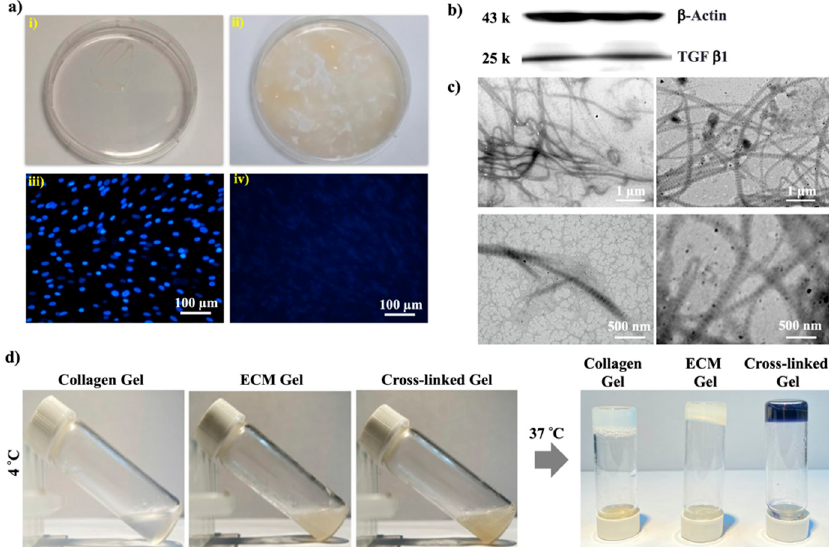
Figure 2. Cell sheet characterization: ( a ) (i) single ADSC sheet, (ii) ASDC sheet collection, (iii) ADSC sheet with typical round-shaped nuclei stained with 4 ′ 6-diamidino − 2-phenylindole (DAPI), and (iv) decellularized ADSC sheets with irregularly shaped nuclei and weak DAPI staining; ( b ) transforming growth factor (TGF)- β 1 in the extracellular matrix (ECM) by Western blotting analysis; ( c ) TEM analysis of collagen and ECM gel; ( d ) gross observation immediately after adding genipin (4 °C) and gel formation at 37 °C.